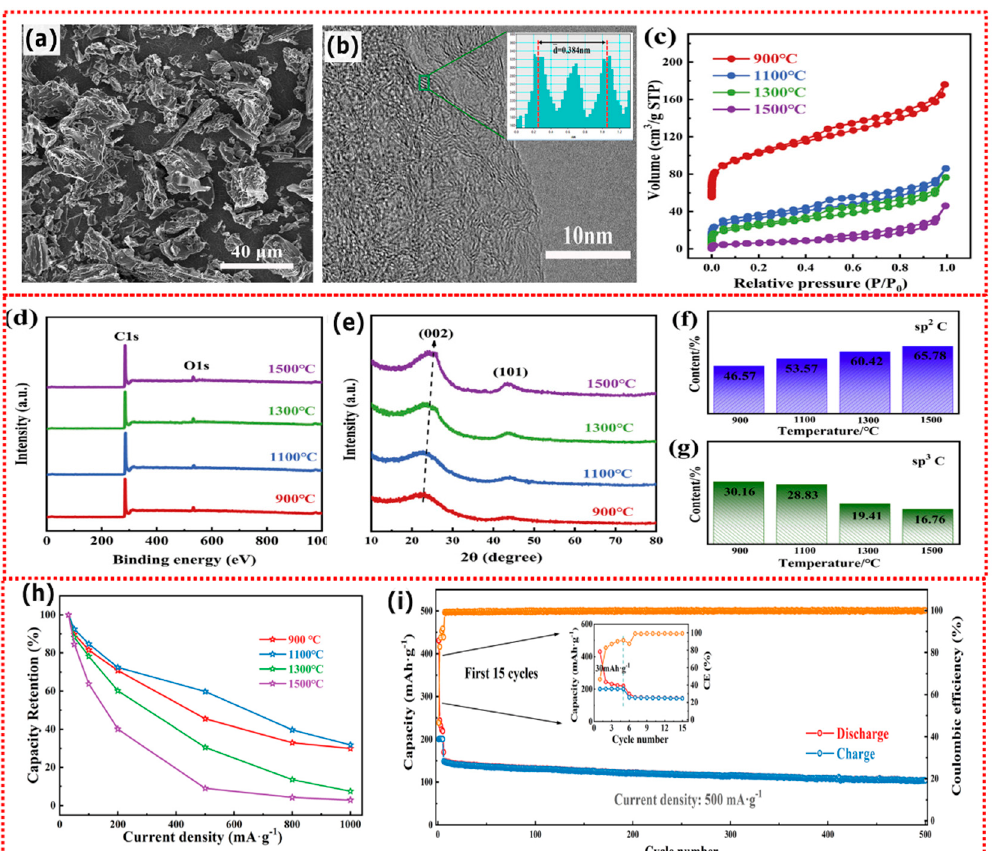
Figure 3. ( a ) SEM image of rice husk carbon anode; ( b ) TEM image of rice husk carbon anode; ( c ) N 2 adsorption/desorption of rice husk carbon anodes; ( d ) XPS spectra of rice husk carbon anodes; ( e ) XRD patterns of rice husk carbon anodes; ( f , g ) Carbon states content as a function of the temperature of rice husk carbon anodes; ( h ) Comparison of capacity retention of KIB cells at increasing current densities among different carbon anodes; ( i ) Cycle performance of biochar with highest performance (1100 °C) at 500 mA·g − 1 (inset: the first fifteen cycles). Reprinted with permission from ref.